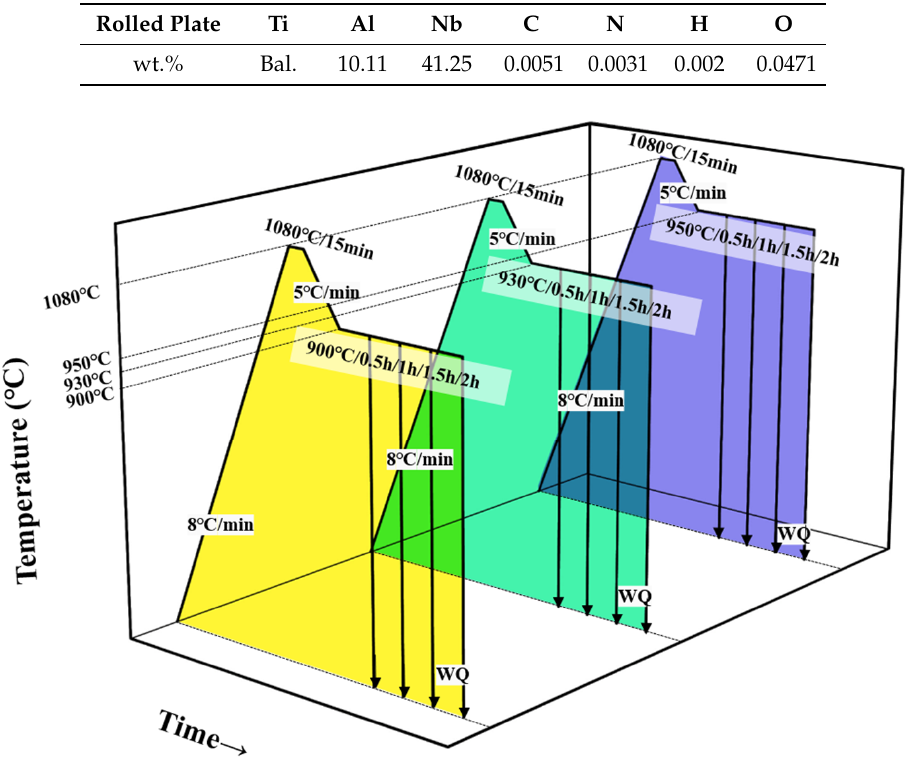
Table 1. The actual composition of Ti-22Al-25Nb alloy used in the present work (wt.%).